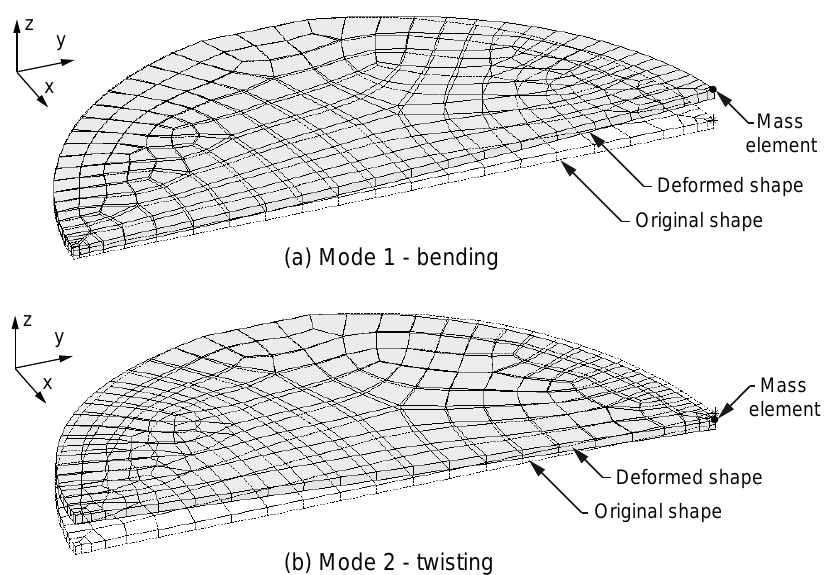
Figure 6. Deformed shapes of ( a ) the bending mode and ( b ) the twisting mode determined by finite element analyses.